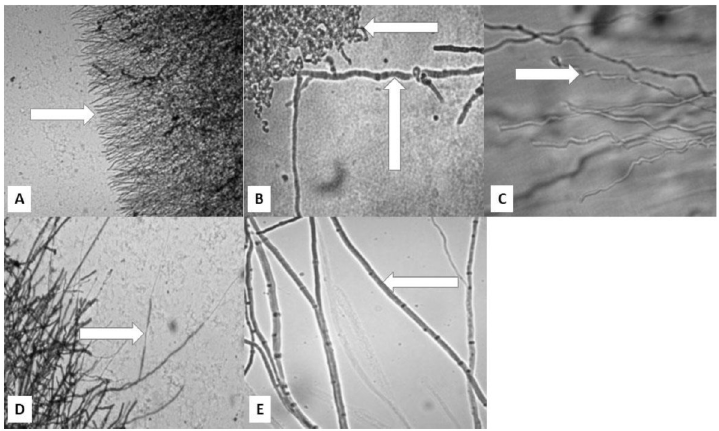
Fig. 3. Microscopical image of hyphal abnormalitiesshowed by arrow: A. stunted, B. curved, C. distorted, D. lysed and dwarfed, and E. normal